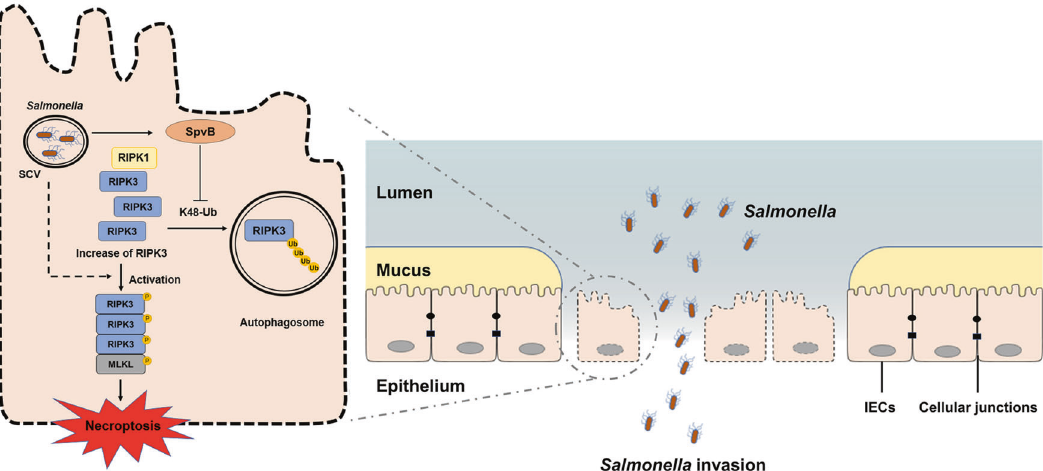
Fig. 7 General summary of SpvB-mediated IECs necroptosis during Salmonella infection. SpvB, an effector encoded by pSLT, downregulates the K48-Ub-degradation of RIPK3 in an autophagy-dependent manner. The abundant accumulation of RIPK3 upregulates the phosphorylation level of MLKL and leads to necroptosis in IECs. The SpvB-mediated IECs necroptosis aggravates the pathogenesis of Salmonella through promoting the bacteria to disrupt intestinal epithelial barrier integrity. IECs, intestinal epithelial cells; SCV, Salmonella - containing vacuole; MLKL, mixed-lineage kinase domain-like protein; RIPK3, receptor-interacting protein kinase 3; RIPK1, receptor-interacting protein kinase